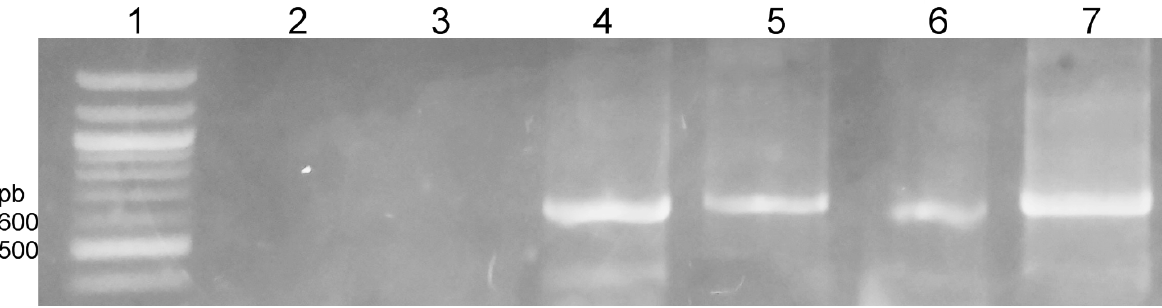
Figure 3: PCR used to detect GH in genomic DNA larvae from 48 h after fertilization with electropored sperm from different treatments. 1) DNA ladder, 2) Eggs without fertilization, 3) PCR mix without template, 4) 0.5 v, 5) 0.75 v, 6) 1.0 v, 7) plasmid with GFP-GH as a positive